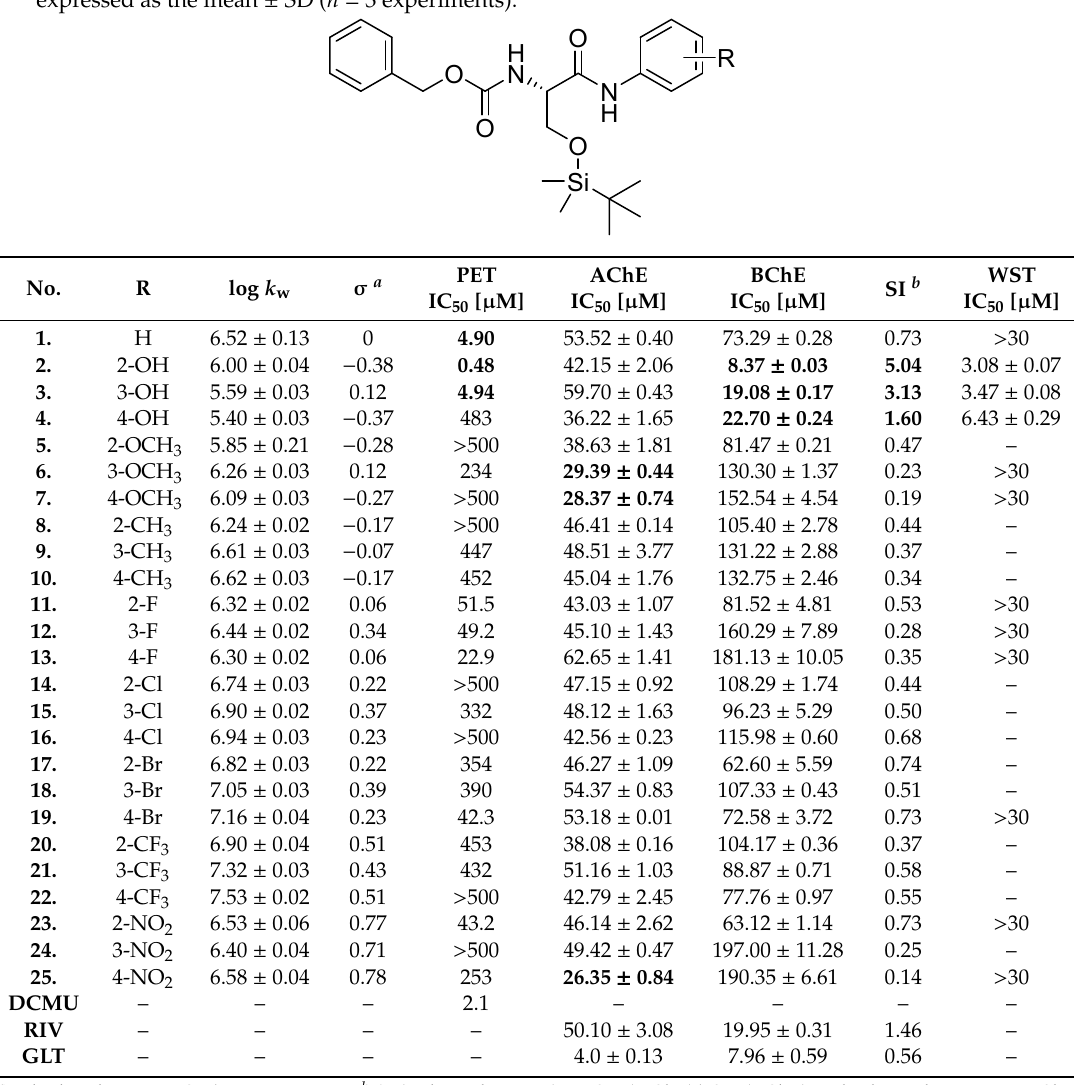
Table 1. Structures of the carbamate derivatives 1 – 25 , experimental log k w values and electronic Hammett’s σ parameters; in vitro PET, AChE and BChE inhibition (IC 50 [ μ M]) compared with standards 3-(3,4-dichlorophenyl)-1,1-dimethylurea (DCMU) rivastigmine (RIV) and galanthamine (GLT) and in vitro viability (WST) assays (IC 50 [ μ M]) of investigated compounds. ChE inhibition is expressed as the mean ± SD ( n = 3 experiments).